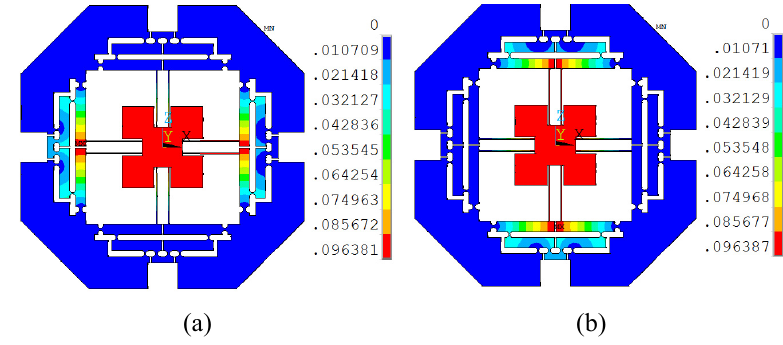
Figure 9. Deformations: (a) input at x direction and (b) input at y